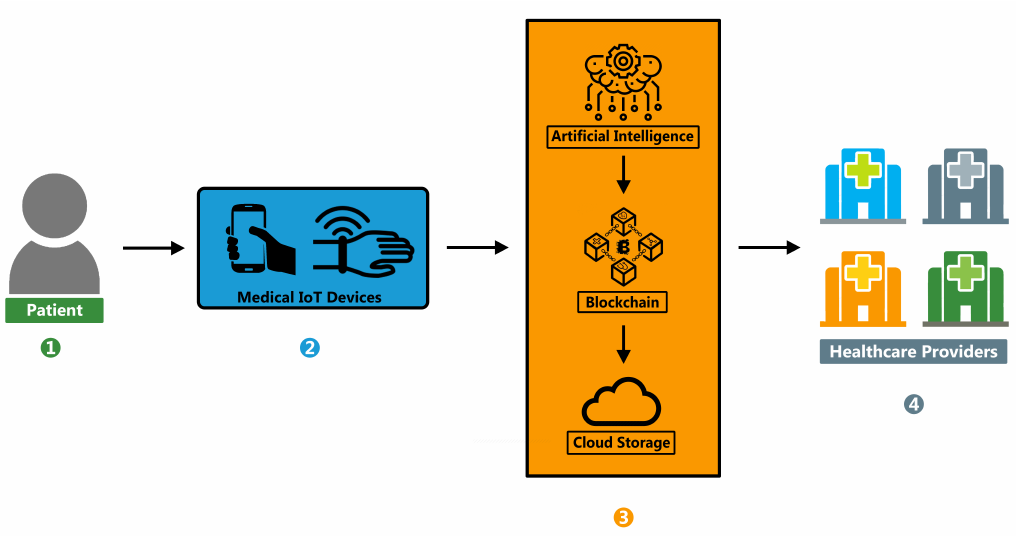
Figure 5. Internet of medical things (IoMT) in